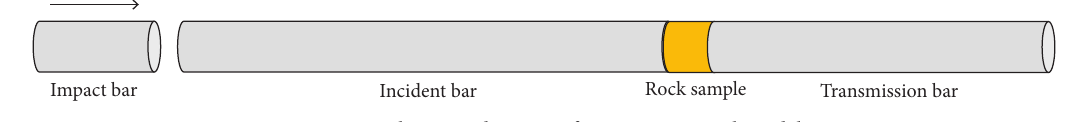
Figure 2: Schematic diagram of SHPB numerical model.